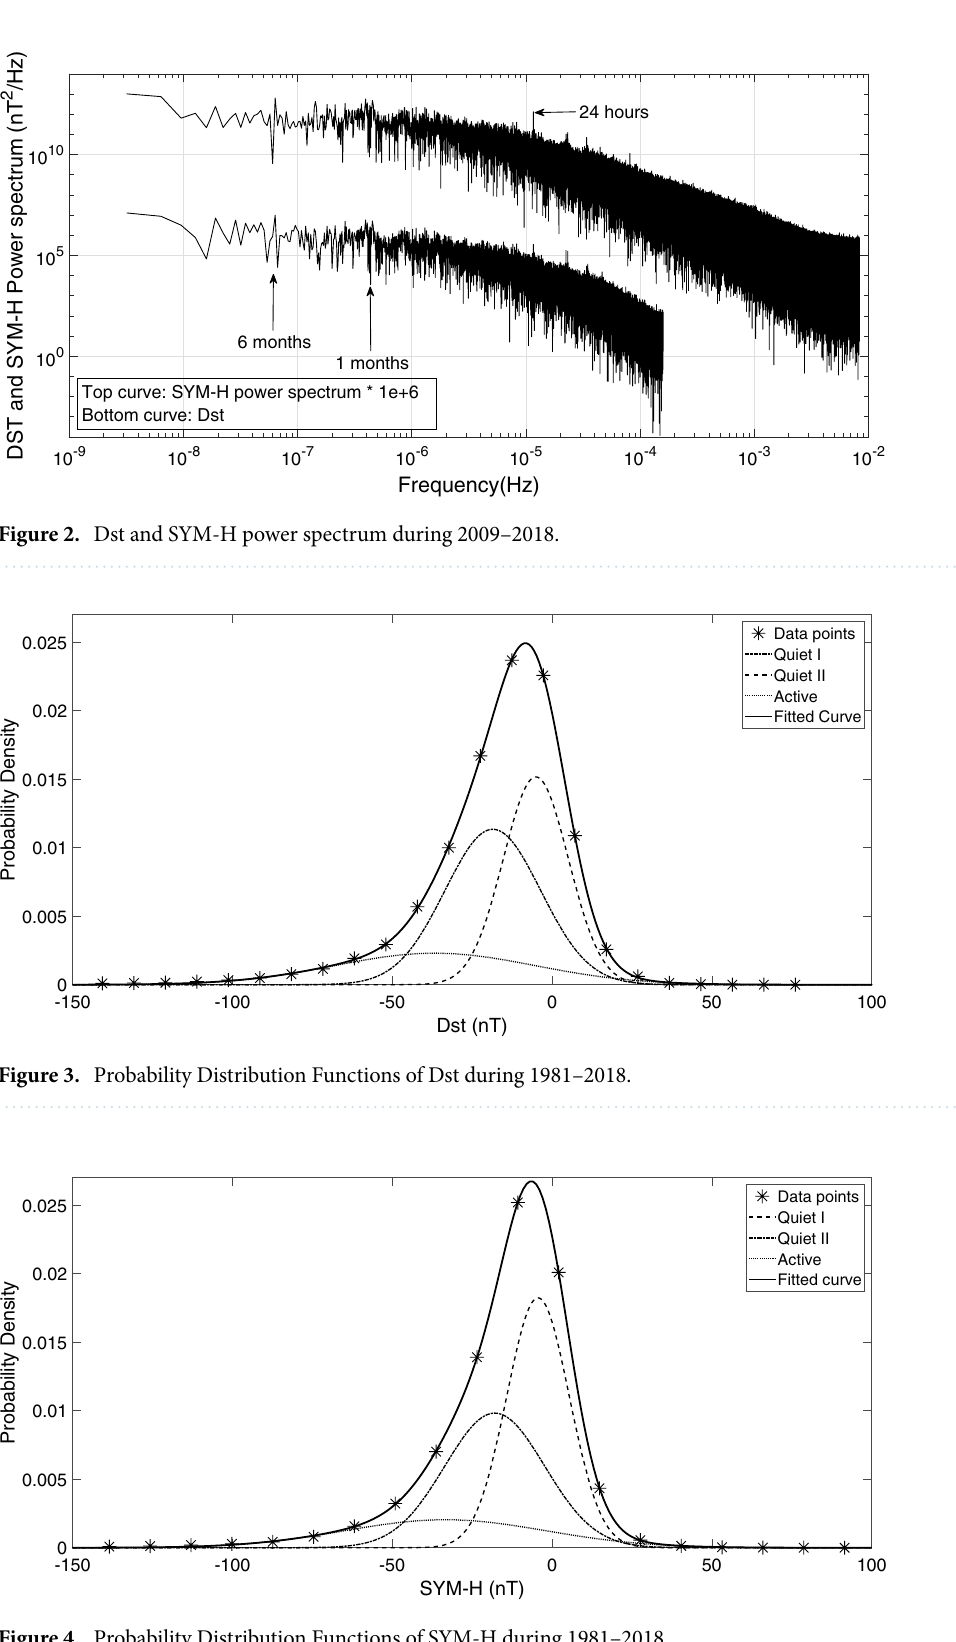
Figure 4. Probability Distribution Functions of SYM-H during